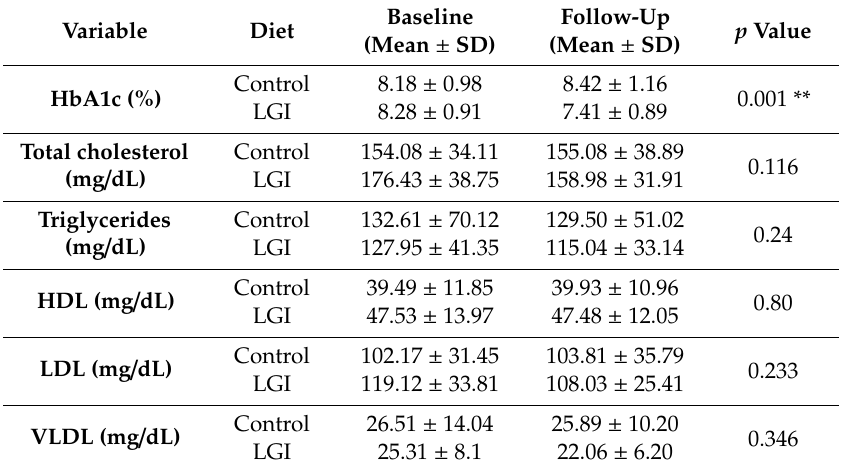
Table 4. Metabolic parameters of low GI and control diets in people with type 2 diabetes.